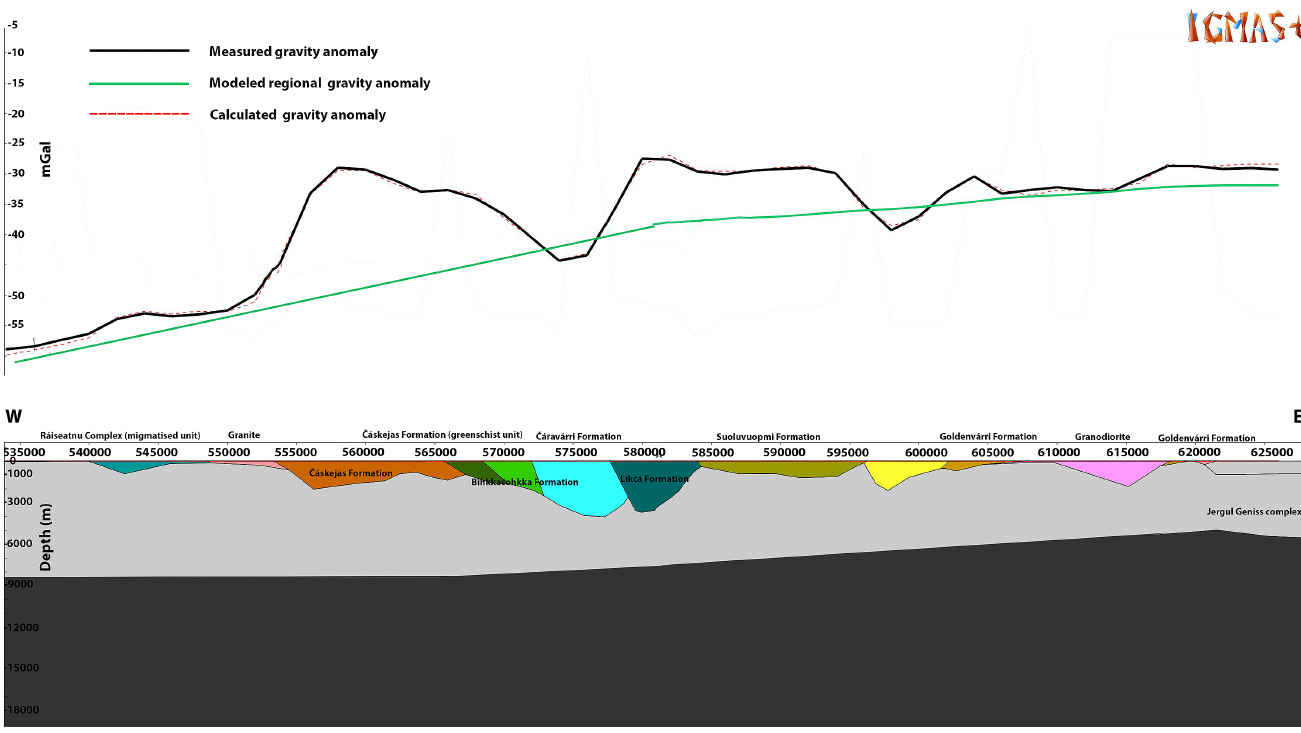
Figure 18. Selected vertical slice 5 (P5) through the 3D density/structural model in Fig. 12. The black line shows the measured data. The dashed red line depicts the modelled data, and the green line shows the regional